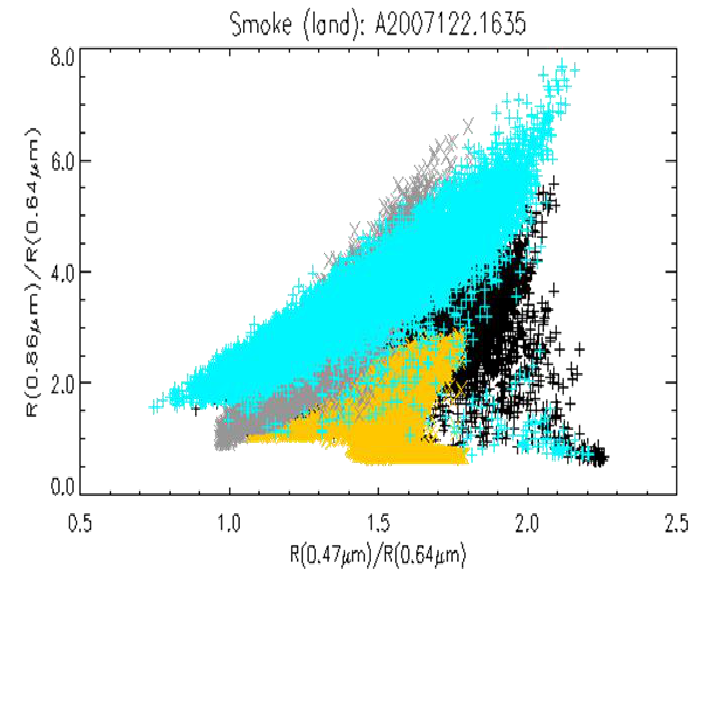
Figure 8. Scatter plots of R pixels (blue), smoke pixels (dark), heavy smoke pixels (yellow), and cloudy pixels